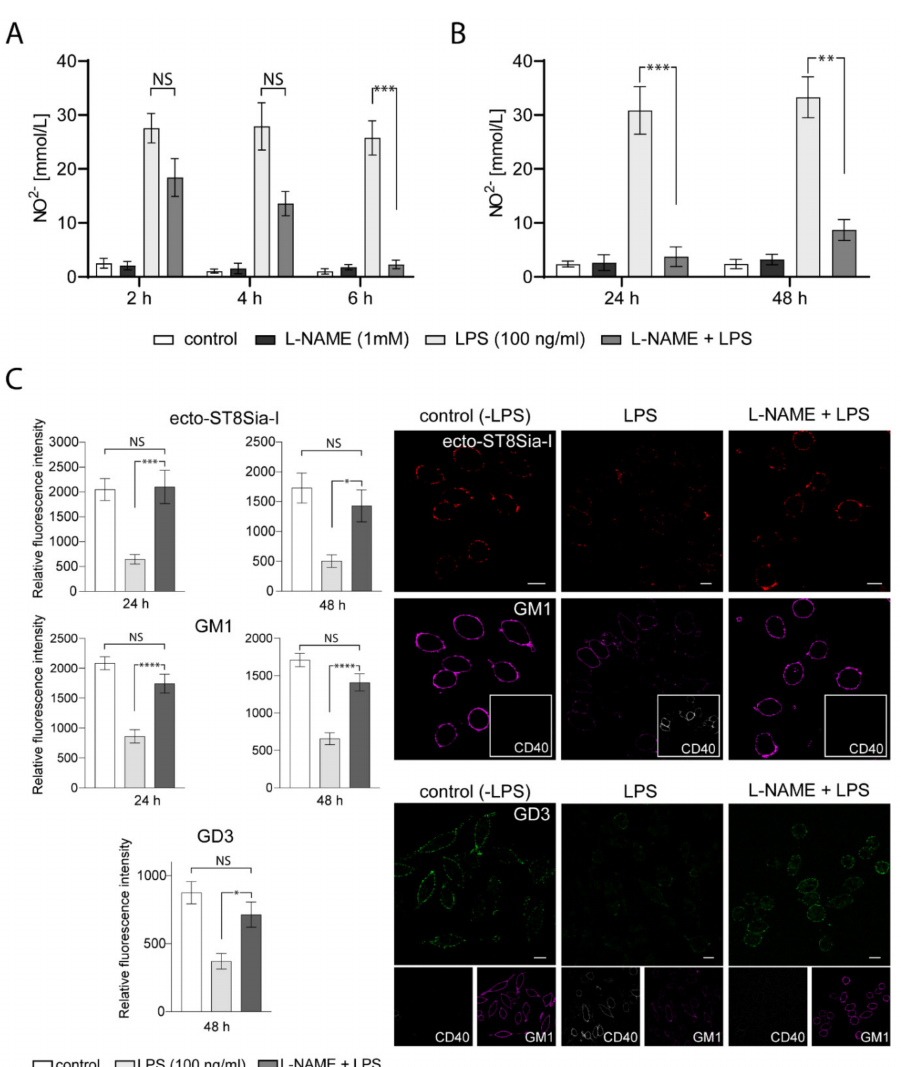
Figure 5. E ff ect of L-NAME on ST8Sia-I levels at the plasma membrane of LPS-treated macrophages. ( A ) Four experimental groups were used: Cells untreated (control), cells pretreated with 1 mM L-NAME (L-NAME), cells stimulated with LPS (LPS 100 ng / mL) for 24 h and cells pretreated with 1 mM L-NAME and stimulated with LPS (L-NAME + LPS) at the indicated times. The Nitric oxide (NO) was measured using Griess assay. Data is representative of two independent experiments. One-way ANOVA: F = 14.87, p < 0.0001. Tukey’s multiple comparison test. ( B ) The same experimental groups described in A were used, except that cells were stimulated with LPS for 24 h and 48 h. The NO was measured using Griess assay. Data is representative of three independent experiments. One-way ANOVA: F = 22.27, p < 0.0001. Tukey’s multiple comparison test. ( C ) Cells untreated (control), cells stimulated with LPS (LPS 100 ng / mL) and cells pretreated with 1 mM L-NAME and stimulated with LPS (L-NAME + LPS) were immunostained with CTx β (which binds to GM1) and specific antibodies against the respective sialyltransferase ST8Sia-I, GD3 ganglioside and glycoprotein CD40 at 4 ◦ C for 60 min. Then, cells were fixed, incubated with secondary antibodies and visualized by confocal microscopy. Anti-CD40 PE-conjugated was used as the control of stimulated macrophages. Where indicated, cells were stimulated with LPS for 24 h or 48 h. (ST8Sia-I pseudocoloured red, GM1 pseudocoloured magenta, GD3 pseudocoloured green and CD40 pseudocoloured grey). The levels of ST8Sia-I, GM1 and GD3 were analyzed by quantifying its fluorescence intensity using ImageJ software. Data are expressed as mean ± S.E.M. One-way ANOVA and Tukey’s multiple comparison test were used. (* p < 0.05; ** p < 0.005; *** p < 0.0005; **** p < 0.0001). Scale bars:10 µ